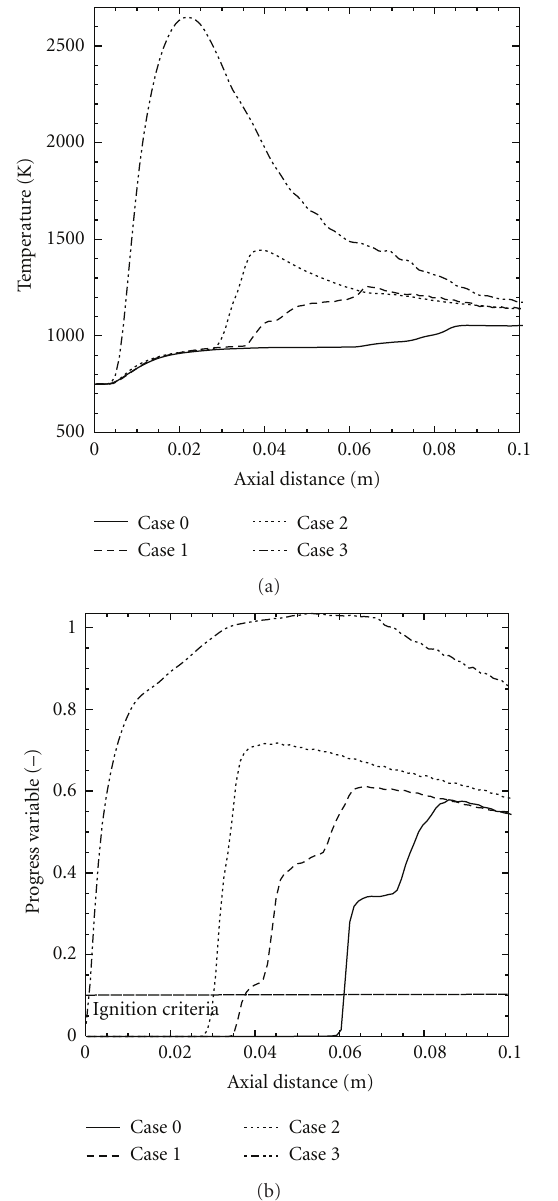
Figure 9: Time averaged resolved temperature (a) and the normal- ized progress variable PV (b) along the axis of the